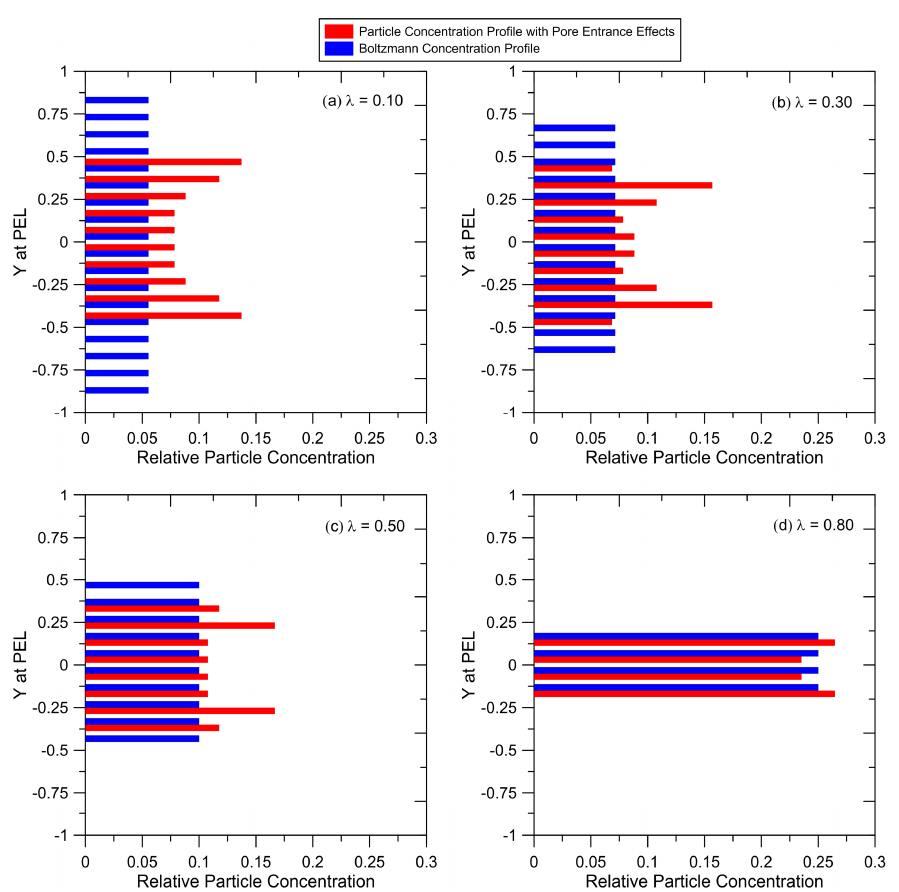
Figure 6. Relative particle concentration profile at the PEL predicted from our pore entrance model compared to a Boltzmann probability for different particle sizes: ( a ) λ = 0.10; ( b ) λ = 0.30; ( c ) λ = 0.50; ( d ) λ = 0.80. Simulations were repeated with 102 particles for each particle size, initially placed at X initial = − 5 and evenly distributed between − 5 < Y initial < +5. The radius of curvature of the pore entrance, r c /( h /2) = 1.